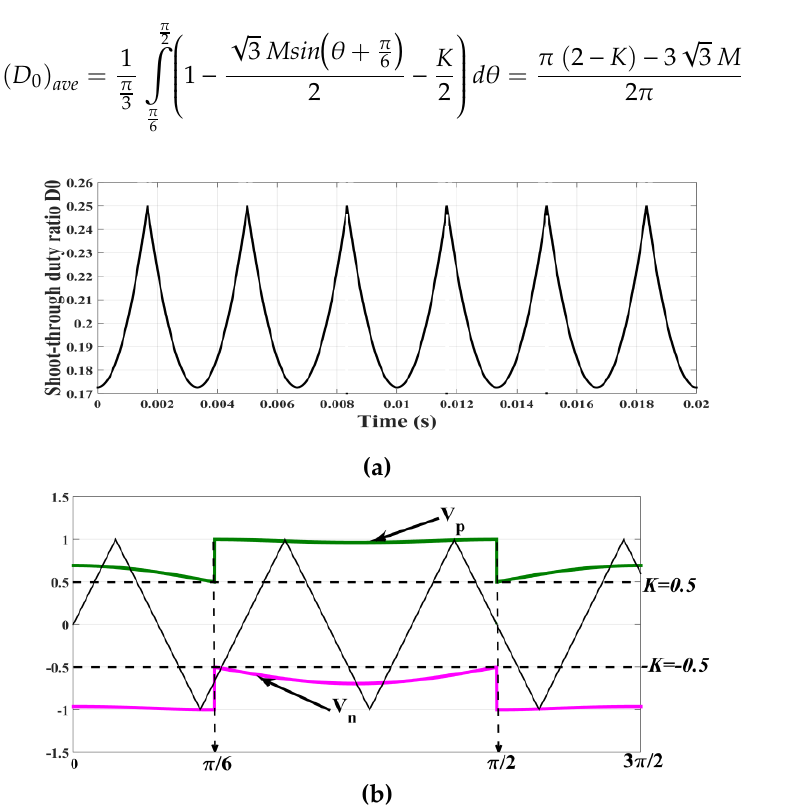
Figure 5. ZSI-DCPWM envelopes: ( a ) Conventional ZSI-DCPWM envelopes, ( b ) Proposed modified DCPWM envelopes.